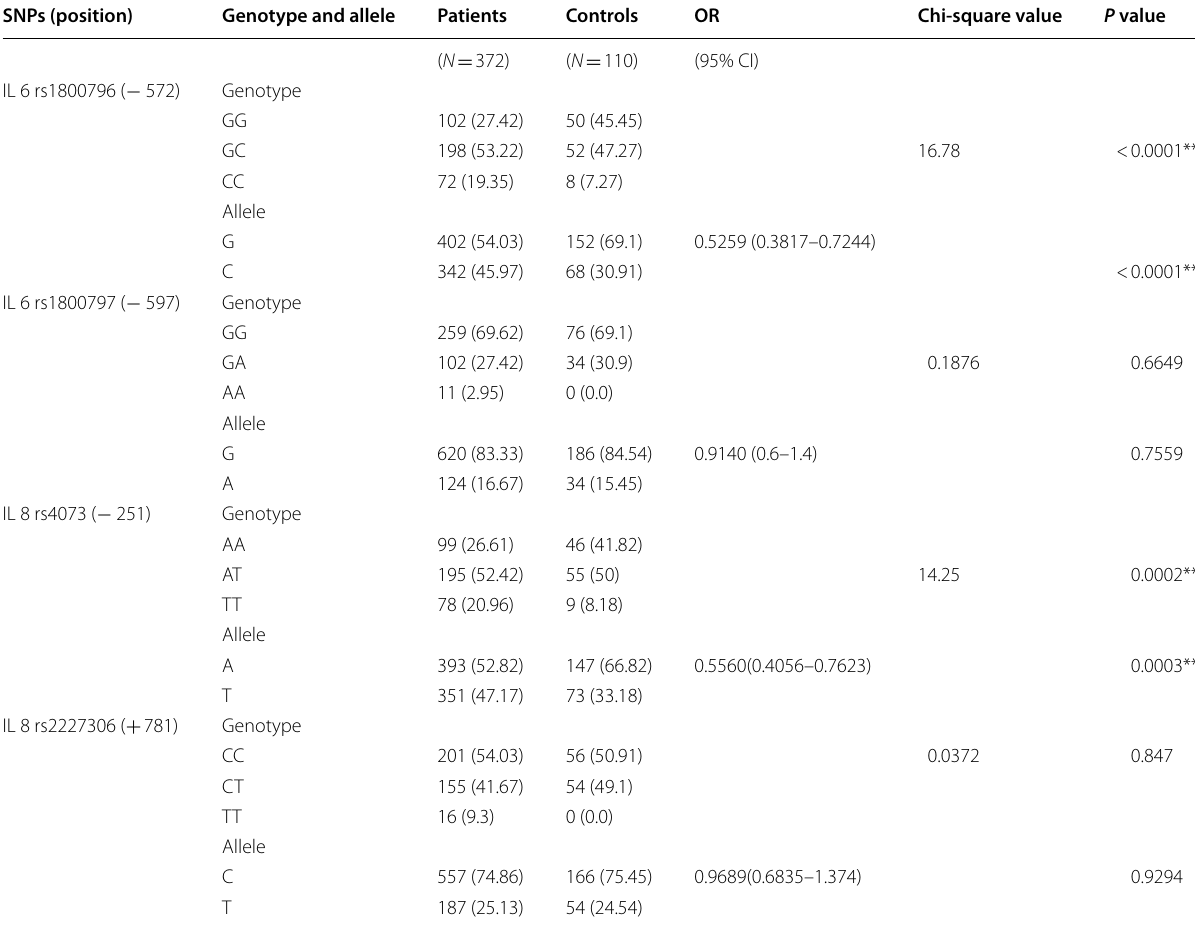
Table 3 Genotype and allele frequencies of IL 6 and IL 8 polymorphisms in control and patient groups (*** signifies p < 0.0001 and values are significant) SNPs